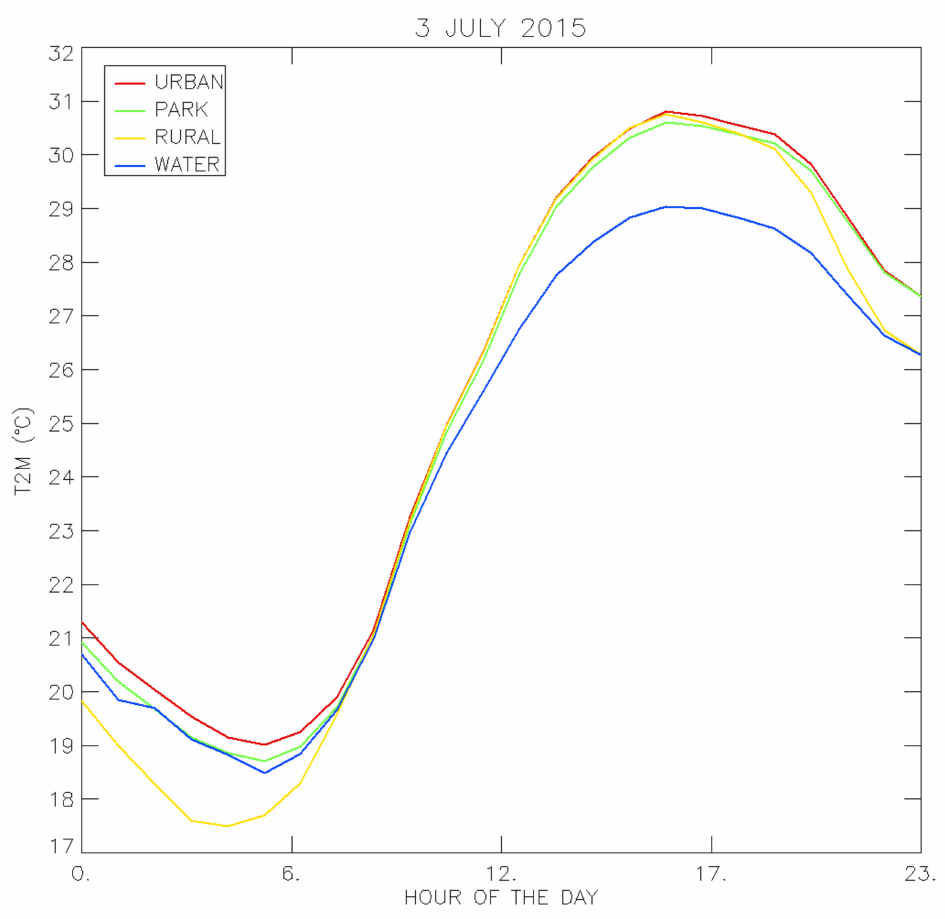
Figure 3. Daily cycle of modelled 2 m air temperatures with an hourly time resolution, averaged per land use class for the focus